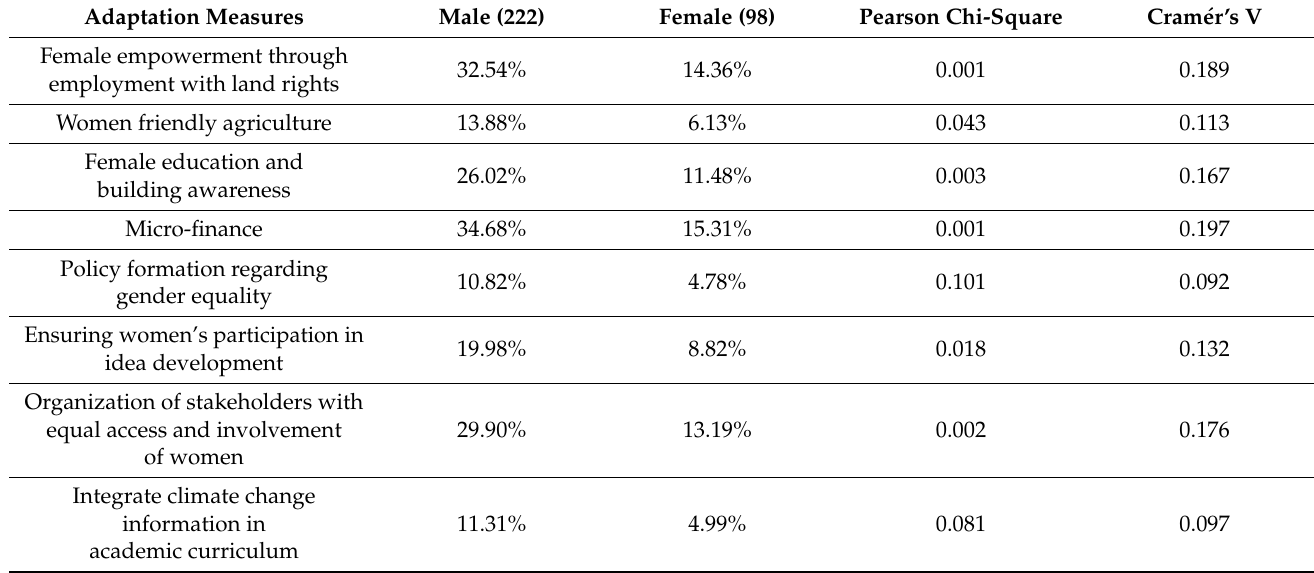
Table 11. refer back to Table 4. types of vulnerability typically faced by women.